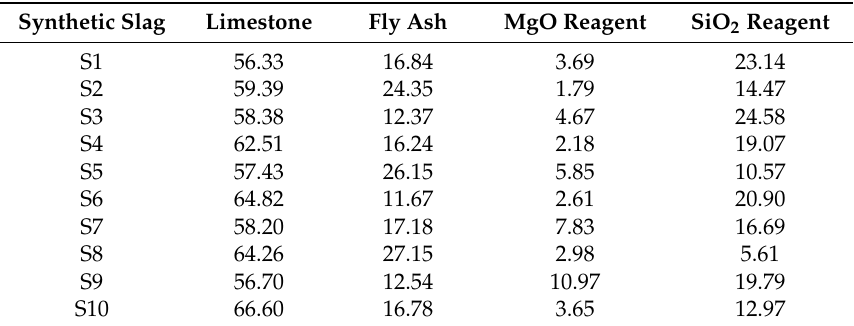
Table 3. The proportions of raw materials for slag preparation